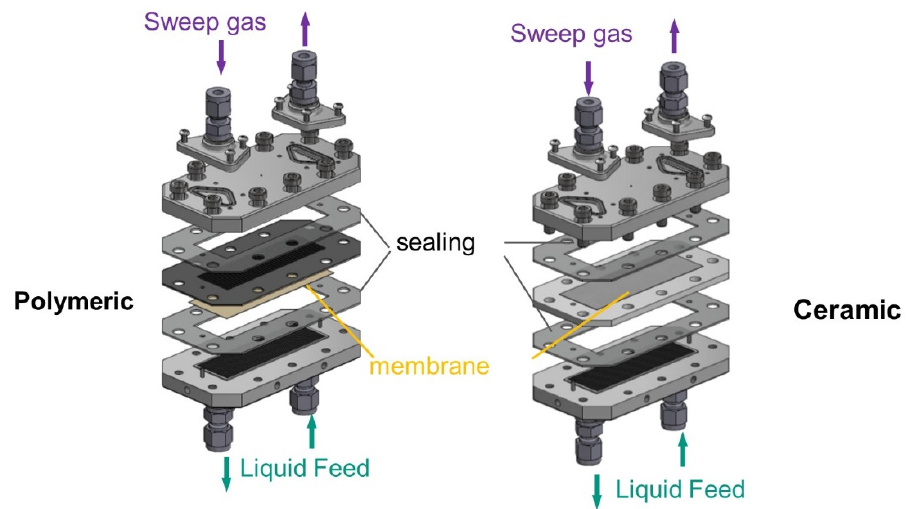
Figure 3. Aluminum test cell used for the LEP pressurized tests; ( Left ) configuration for polymeric membranes; ( Right ) configuration for ceramic membranes.